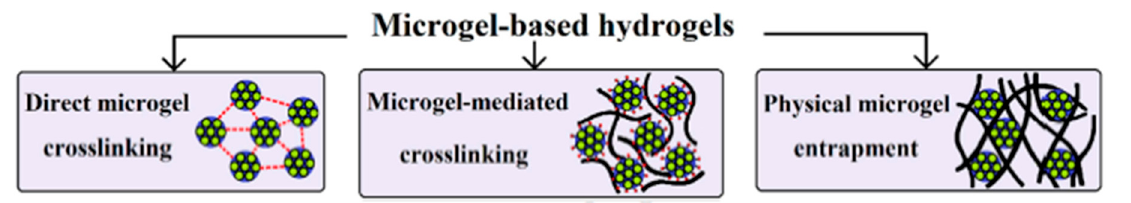
Figure 9. Scheme showing the different preparation methods applied for the production microgel networks. Reproduced with permission from [147], copyright 2017 Elsevier.